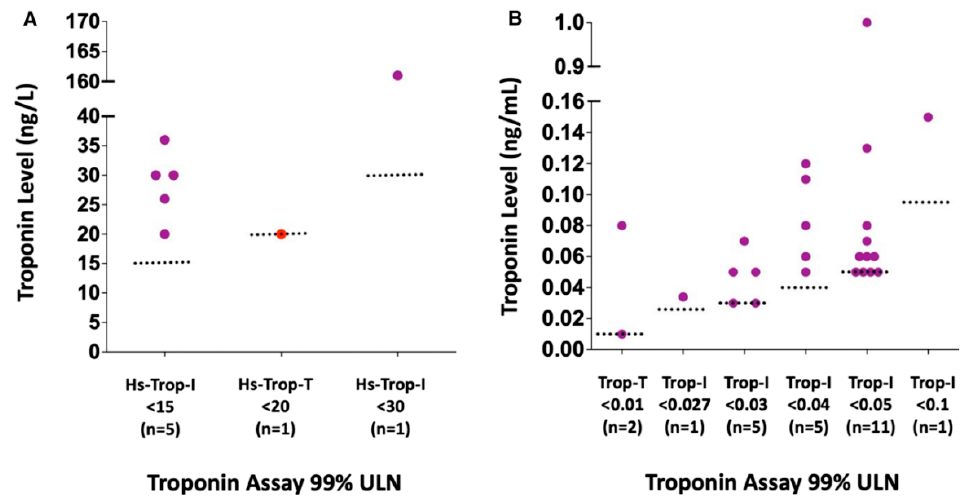
Figure 3. Magnitude of troponin elevation in athletes with abnormal troponin levels. Reproduced from Moulson et al. [32] Open Access, 2022, Journal of American Heart Association . ( A ) High-sensitivity troponin assays. ( B ) Traditional troponin assays. Red dots indicate probable or definite SARS-CoV-2 myocardial involvement. Purple dots = athletes with abnormal troponin but no evidence of probable or definite SARS-CoV-2 myocardial involvement; red dots = athletes with abnormal troponin and evidence of probable or definite SARS-CoV-2 myocardial involvement. Hs indicates high sensitivity. Trop: troponin; Trop-I: troponin-I; Trop-T: troponin-T; and ULN: upper limit of normal.